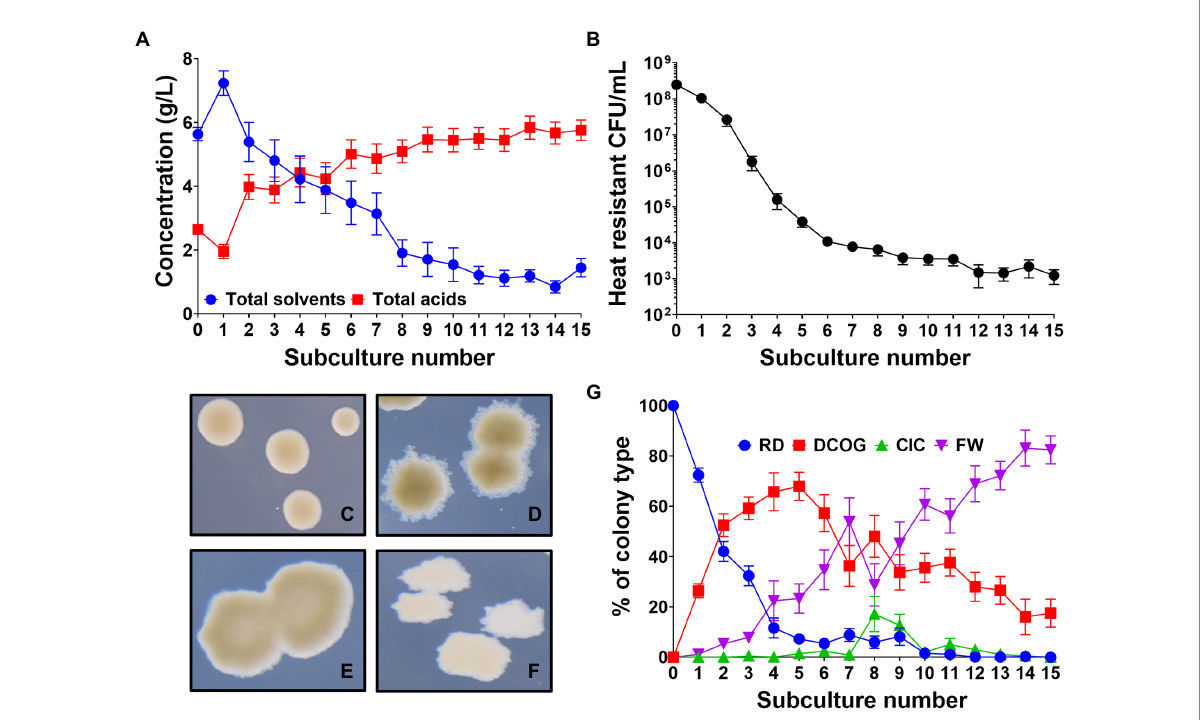
FIGURE 1 Clostridium beijerinckii culture dynamics throughout the degeneration process. (A) Concentration of fermentation products (acetone, ethanol, butanol, acetate, and butyrate) produced by the whole culture at each successive subculture. (B) Number of heat resistant spores produced by the whole culture at each successive subculture. (C–F) Four different colony types observed: (C) “round and dark” (RD), (D) “dark centre and outgrowths” (DCOG), (E) “caved in centres” (CIC), and (F) “flat and white” (FW). (G) Percentage of each colony type found during subculturing. Error bars represent standard error of the mean (± SEM). n = 16, for A,B,G